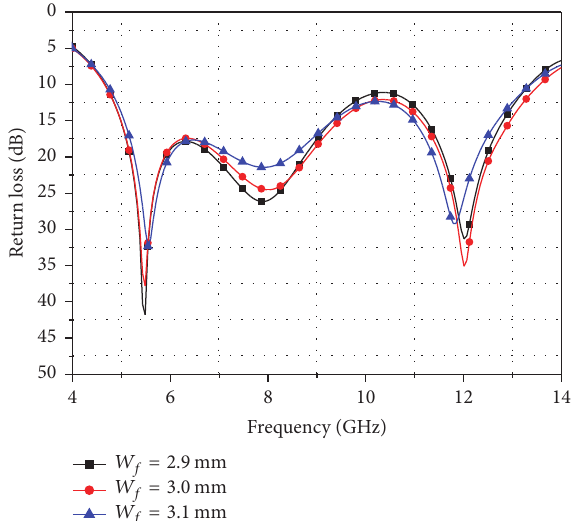
Figure 9: Simulated return loss against frequency for the proposed defected substrate wideband antenna with various 𝑊 𝑓 ; other param- eters are the same as listed in Table